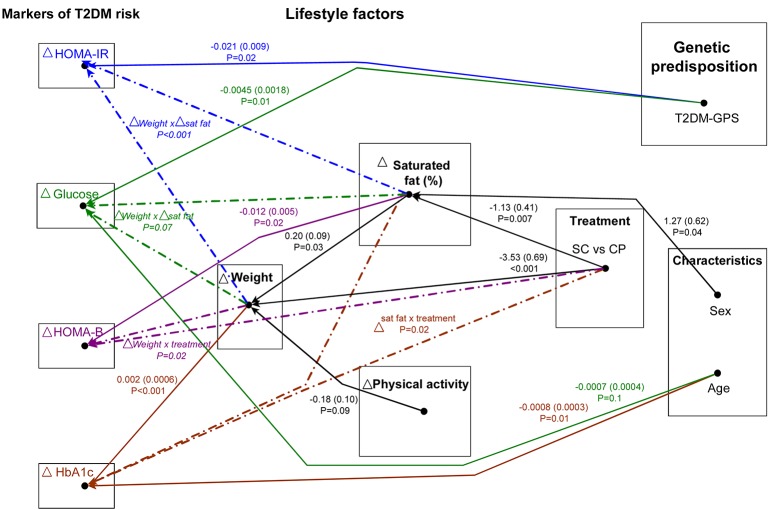
Final graphical Markov models estimated using sequences of regressions.Paths of associations were estimated for changes at 12 months from baseline in HOMA-IR (shown in blue), plasma glucose (shown in green), HOMA-B (shown in purple) and plasma HbA1c (shown in brown). Paths common to all outcomes are shown in black. The arrows represent strong or moderate associations at a significance level of 10%. The strengths of these associations are shown as partial regression coefficients (SE) and P-value for each pair of variables. The partial regression coefficients correspond to changes in the ratio (final/baseline) of the outcome variables in the logarithmic scale. Absence of a line between two variables indicates that they are not associated after conditioning out their combined set of explanatory variables. Significant interactions which were identified are also indicated with dot-dash lines and are detailed in Fig 3. Differences by countries were found, but the effects are not presented for clarity of main findings in the figure. The German centre had significant differences in mean measurements compared to the UK centre for the change in proportion of dietary saturated fat (P<0.1) and physical activity (P<0.1). There were also important differences between the Australian and UK centres in changes of plasma glucose (P = 0.001). Δ Weight (kg), Δ dietary saturated fat (% of total energy), Δ physical activity (1000 000 steps), genetic predisposition (T2DM-GPS, per increased risk allele), age (years), Δ glucose (mM) and Δ HbA1c (mmol/mol).